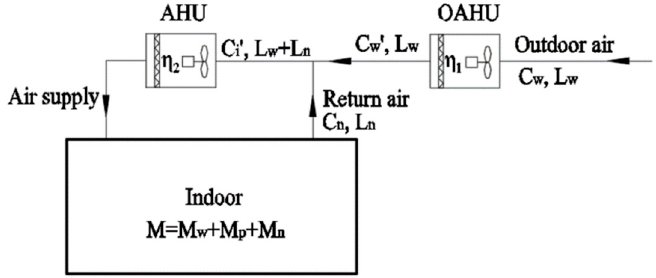
Figure 7. Schematic diagram of a centralized system with outdoor air pretreatment only purifying